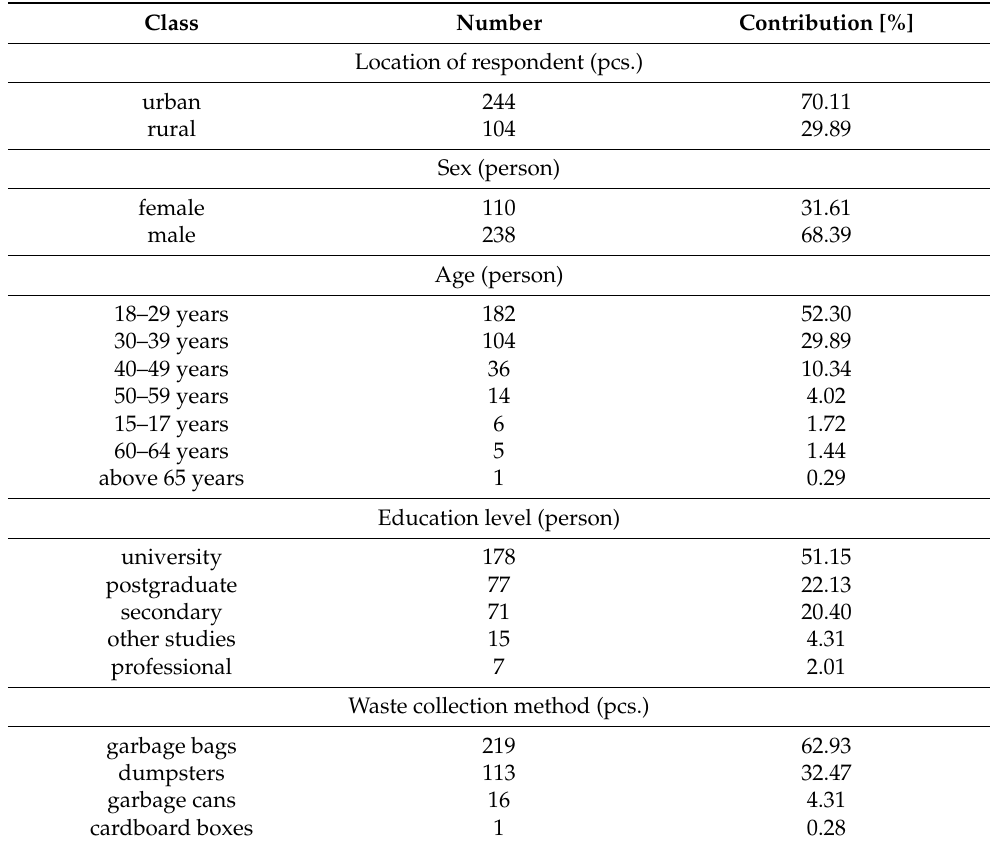
Table 1. Table indicating the studied parameters’ frequency analysis by classes, amount and waste collection